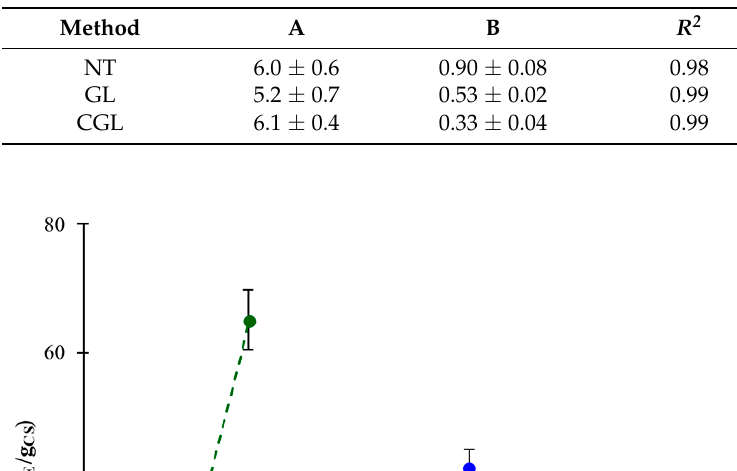
Table 2. Parameters of the Halsey equation (Equation (5)).